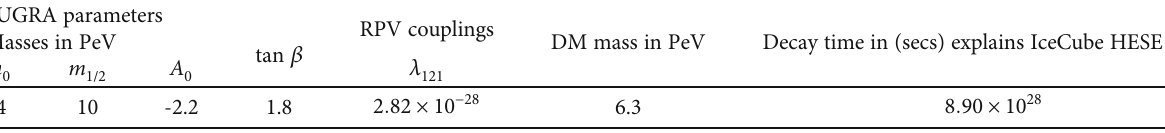
Figure 5: Decay diagrams of neutralino via lepton number violating coupling which produces the IceCube fl ux. Table 2: A list of the benchmark points (BP) as used in our analysis. Using these BPs, we have reproduced the Higgs mass at ~ 125 GeV and explain the relic density and the PeV neutrino events seen at the IceCube experiment. SUGRA parameters RPV couplings DM mass in PeV Decay time in (secs) explains IceCube HESE eventsMasses in PeV tan β m